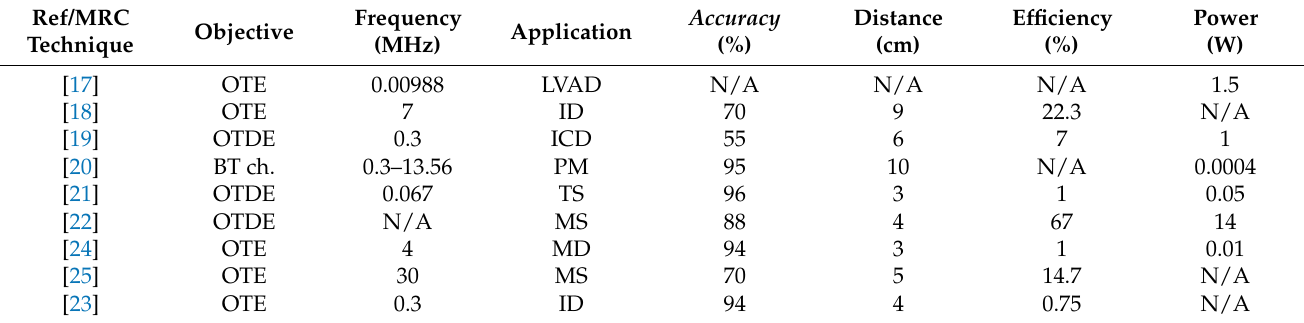
Table 1. Performance metrics of previous